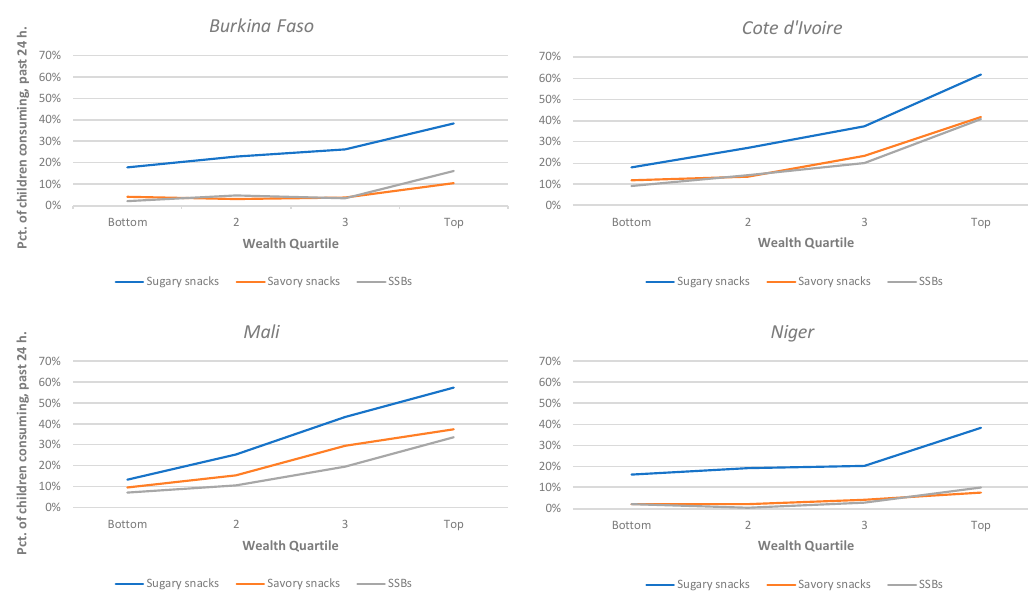
Figure 1. Percentage of children consuming snacks and sugar-sweetened beverages (SSBs) in past 24 h by wealth quartile.